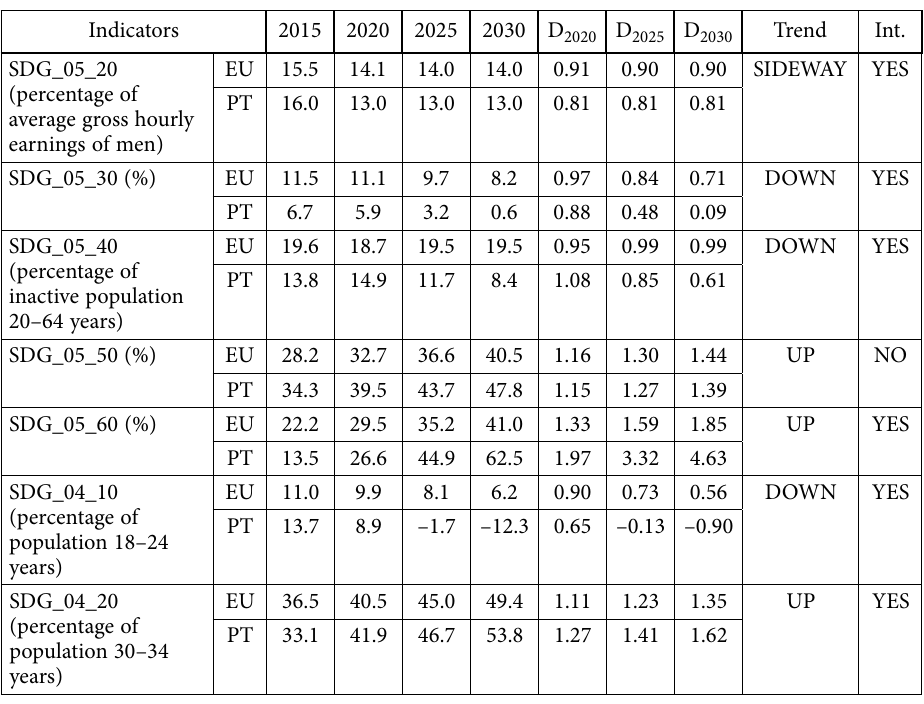
Table 6. SDG 5 – Gender equality Indicators